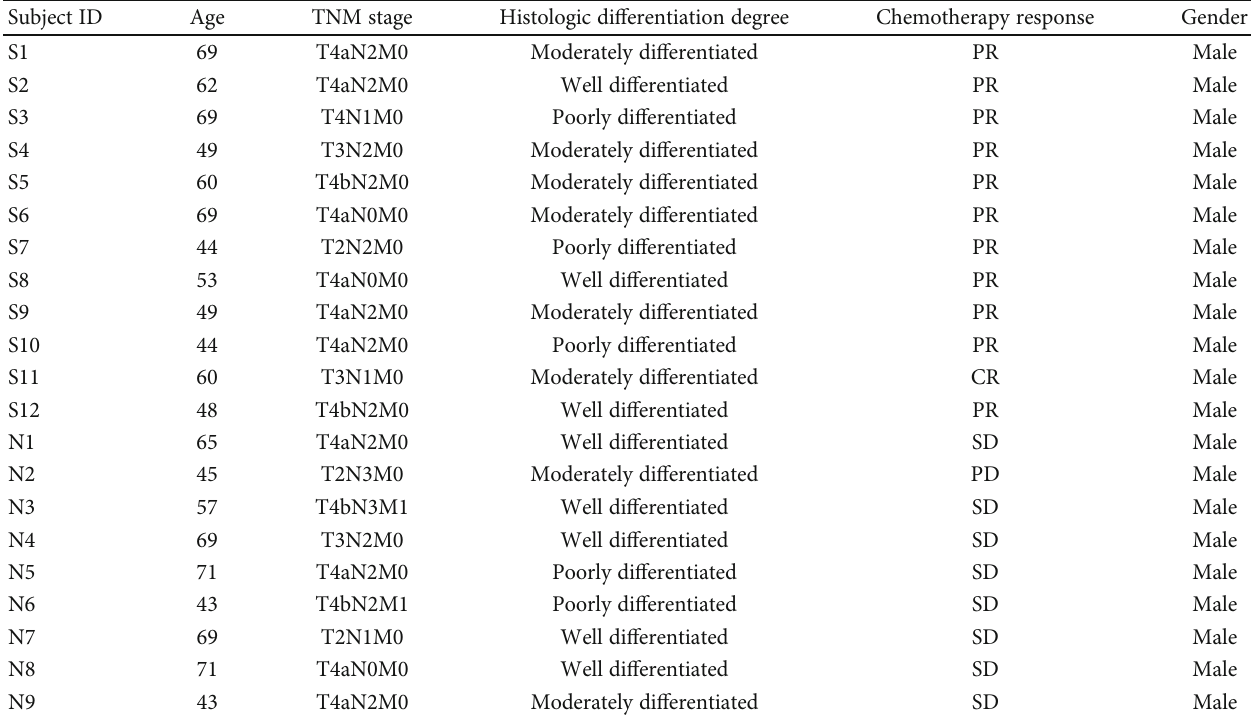
Table 1: Clinical data of HSCC patients for